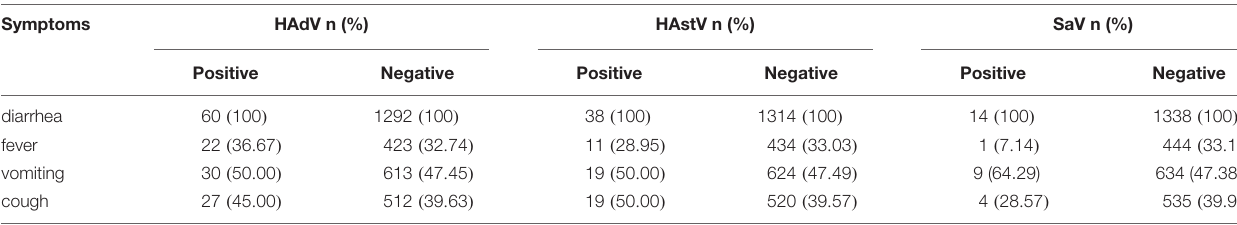
TABLE 2 | Clinical symptoms of diarrhea children infected with and without HAdV, HAstV and